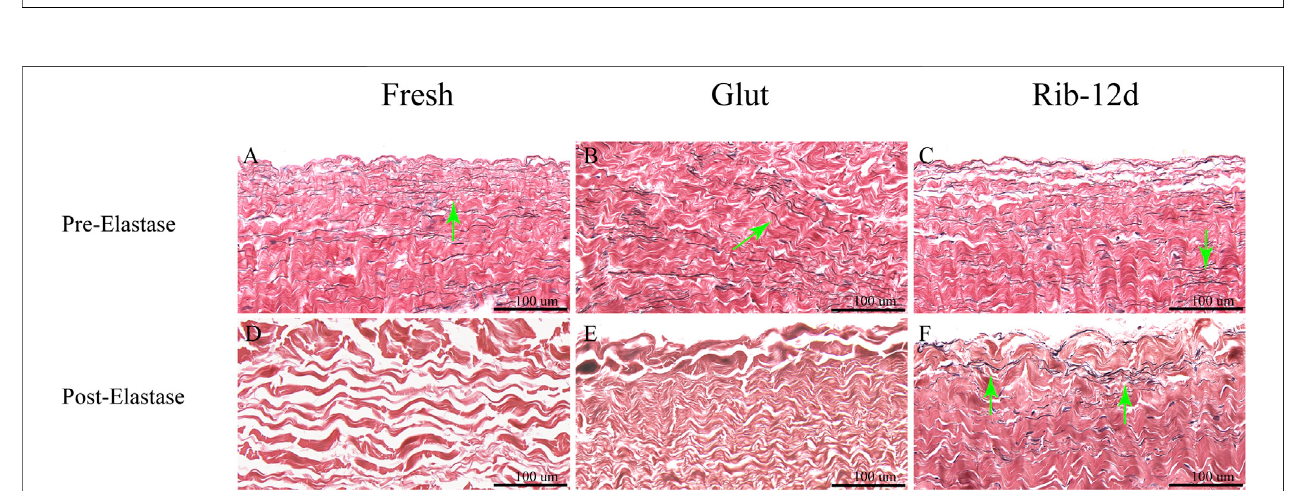
FIGURE 7 | Resistance to the elastase enzymatic challenge of the BP with elastic van-Gieson (EVG) staining. (A,D) Fresh BP. (B,E) Glut-treated BP. (C,F) Rib- treated BP. Elastin are stained black strips (green arrow). Scale bars: 100 μ m (A – F) .